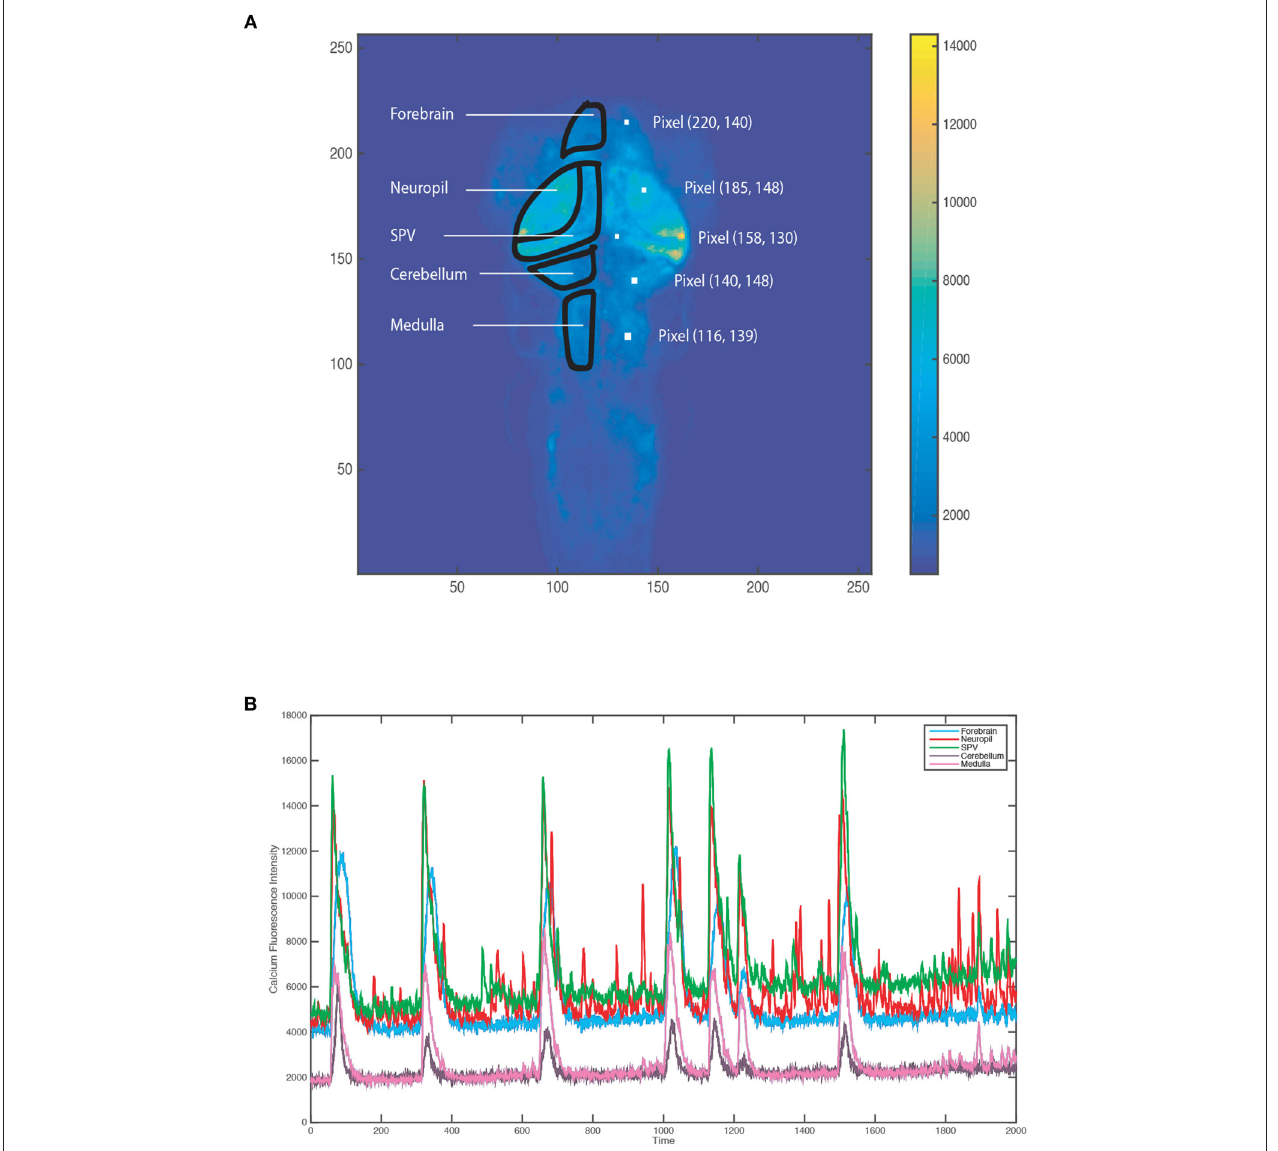
FIGURE 1 | Zebrafish marked with five brain regions and color-coded observed pixel values (as being indicated in the color-bar) (A) and five examples of regional calcium intensity time series (B) .